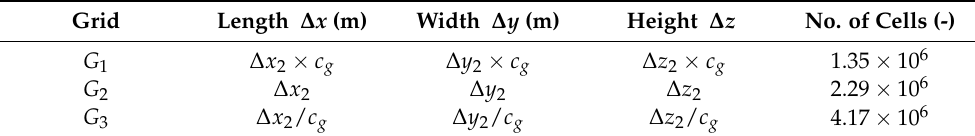
Table 5. Cell grid ratios and the associated number of cells for each grid. Grid Length ∆ x (m) Width ∆ y (m) Height ∆